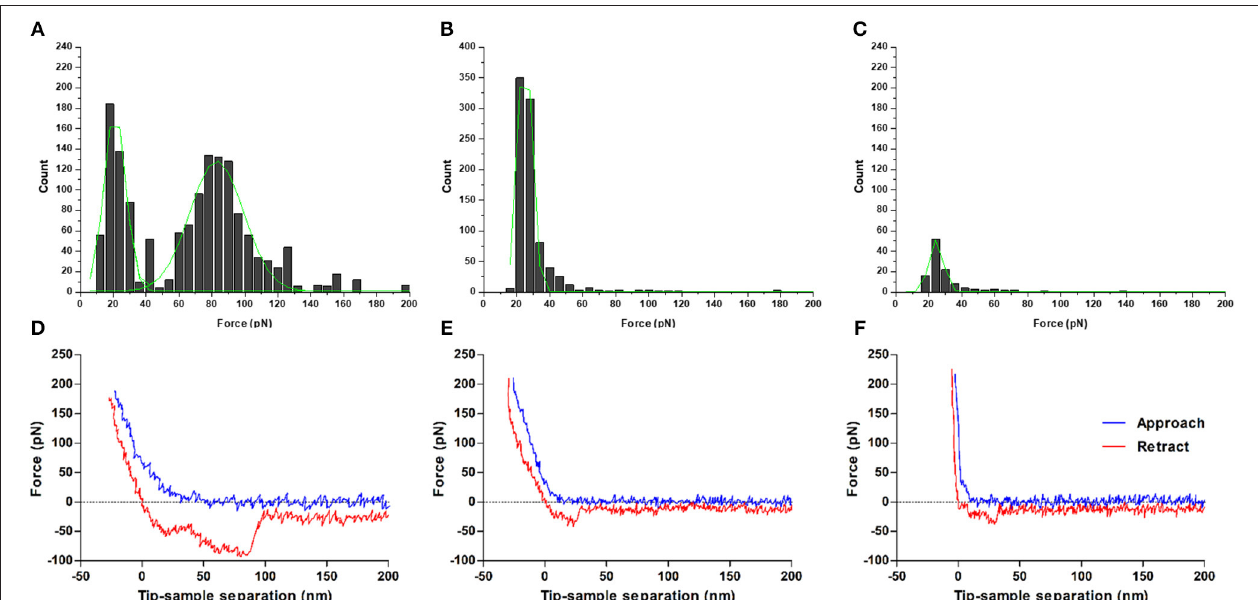
FIGURE 5 | Force rupture histograms of WNV C interaction with plasma lipoproteins, obtained by AFM-based force spectroscopy. Experiments were performed in TEE buffer with 100mM KCl for VLDL (A) and LDL (B) , as well as in TEE buffer with 100mM NaCl for VLDL (C) . The single peak of weak rupture forces observed in (B) and (C) correspond to unspecific interactions. Strong and specific interactions only occur for the interaction of WNV C with VLDL in the presence of potassium ions. Gaussian fitting lines of each individual peak are shown in green. Examples of approach-retraction curves acquired during the force spectroscopy experiments of